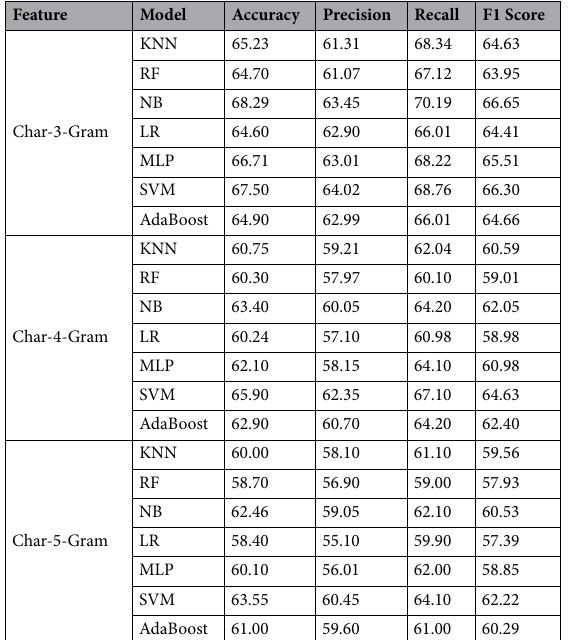
Table 7. Urdu sentiment analysis results using machine learning models with char n -gram features.